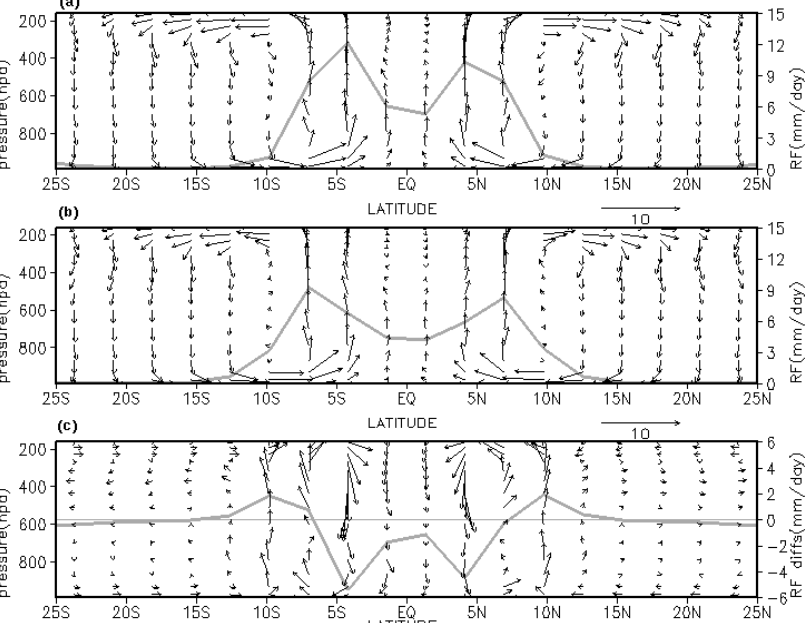
Fig. 13. Zonally averaged time mean meridional circulation (vector arrows: v ; 50 × w ) and rainfall (grey line) for (a) α =0.0, and (b) α =0.7 and (c) ( α =0.7)–( α